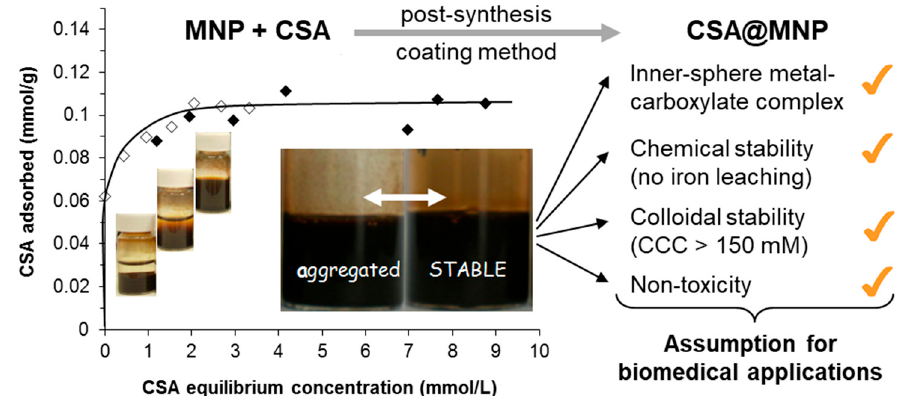
Figure 3. Adsorption isotherm of chondroitin-sulfate-A (CSA) on magnetite nanoparticles (MNP) at pH ~6.3 in aqueous NaCl solution (left side). With increasing CSA concentration, the colloidal state of samples changes characteristically from aggregated to stable, as seen in the vials. The inserted larger photos clearly show the difference between the well stabilized and aggregated magnetic fluids (the amount of CSA is expressed through the number of repeating units in mmol.) Some assumptions of biomedical application are listed in the right side of figure. Reprinted from Reference [94] under the terms of CC by 4.0.